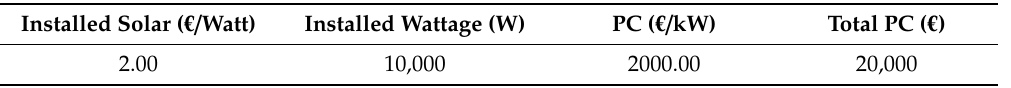
Table 2. The investment costs for new equipment (Germany).